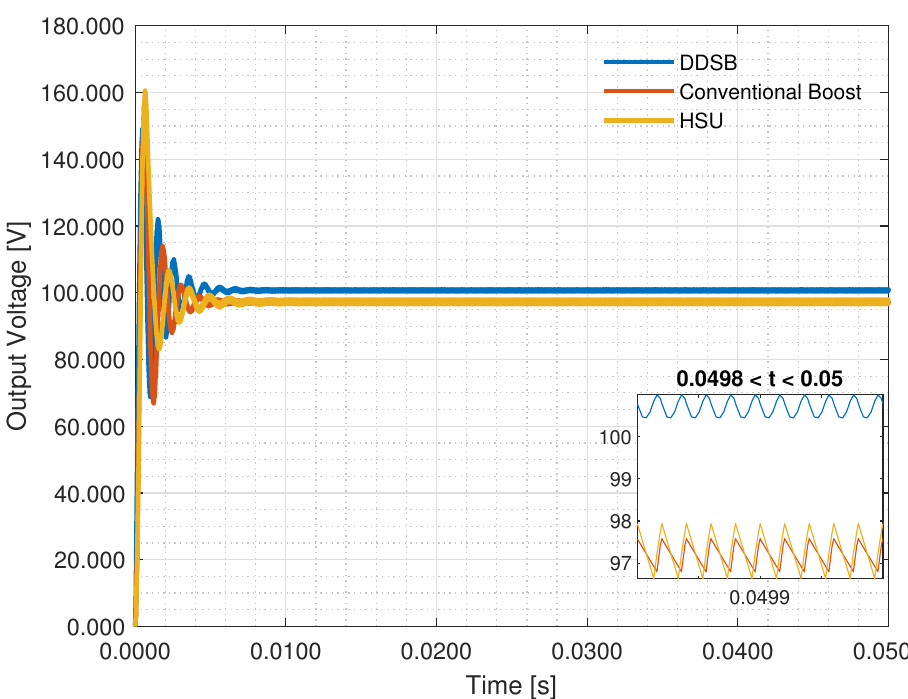
Figure 6. Comparison of the output voltage of the conventional boost and HSU power converters vs. the DDSB converter.